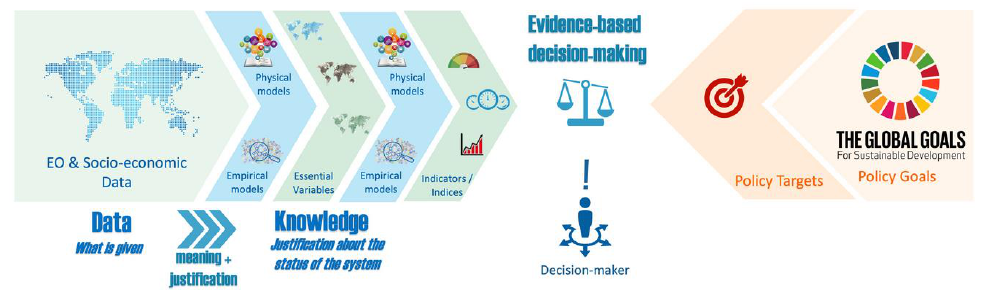
Figure 1. Science-informed decision-making